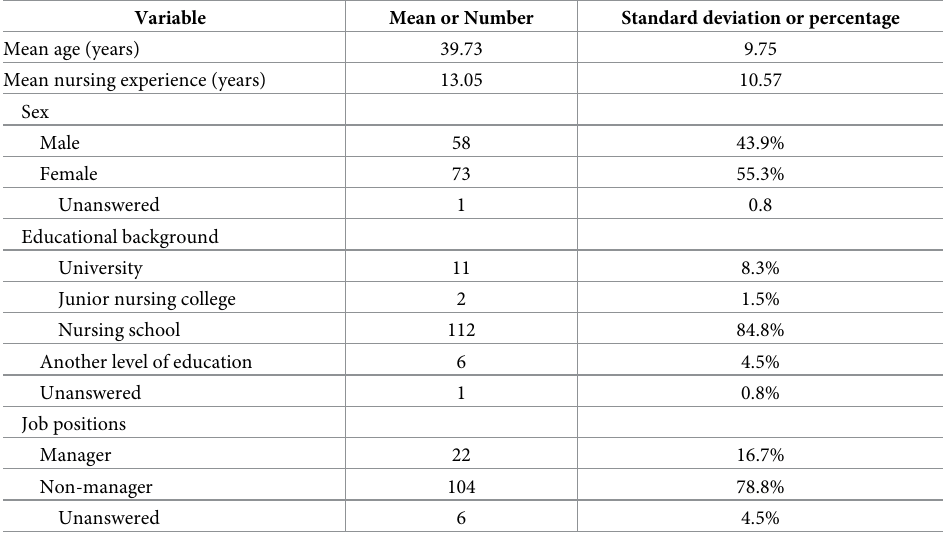
Table 1. Demographic details of